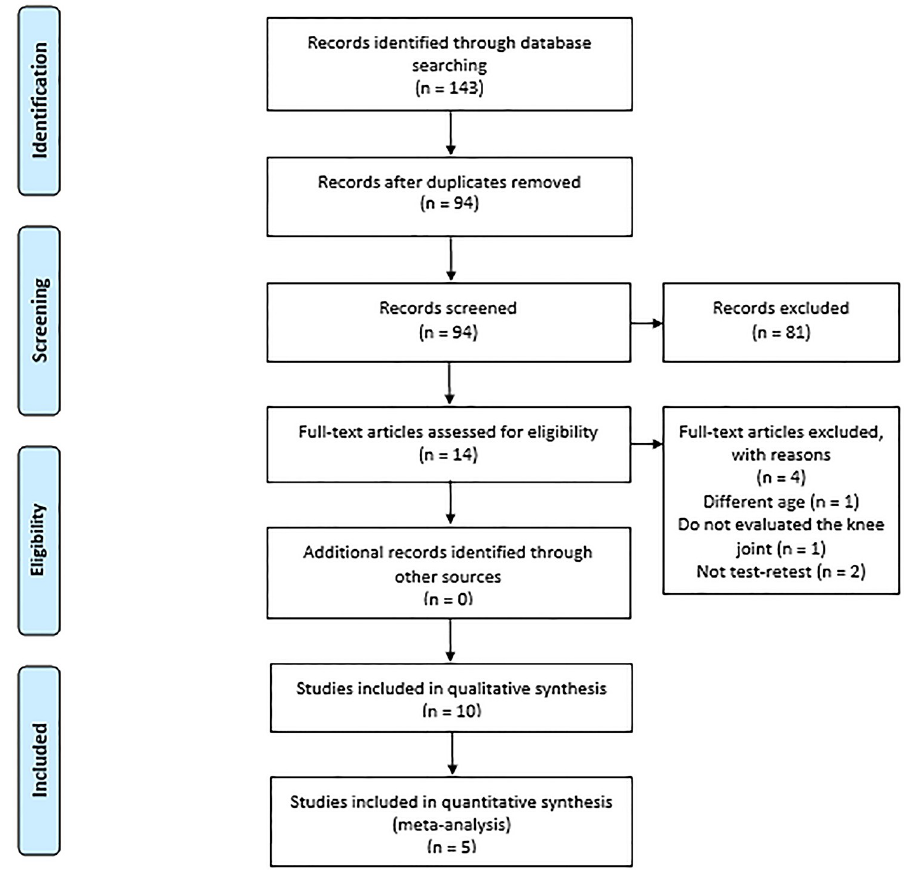
Fig 1. Flow diagram of the search process and selection of documents for the